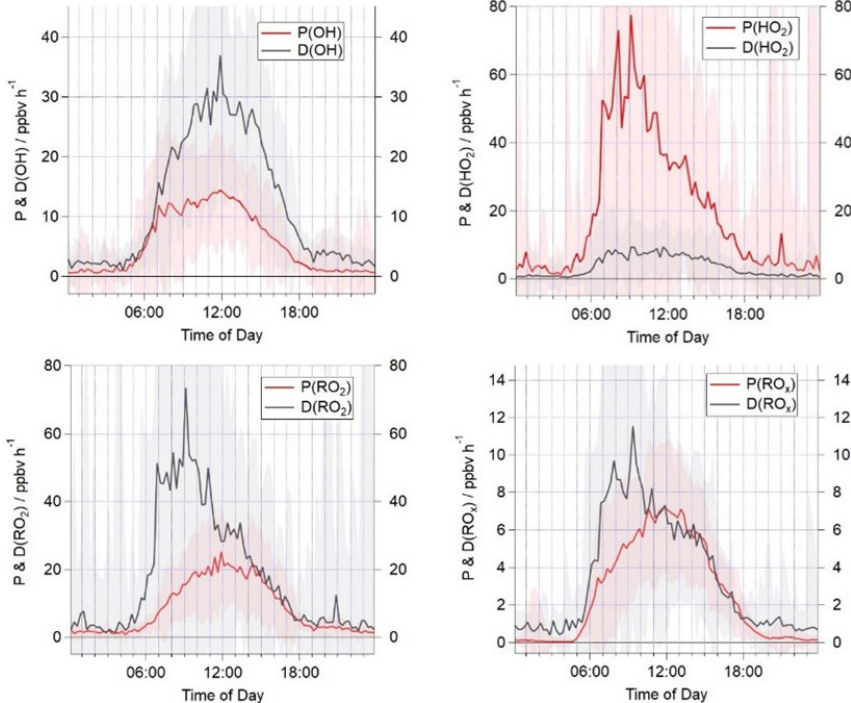
Figure 3. Campaign median production and destruction rates for OH, HO 2 , total RO 2 and RO x . The shaded areas represent the 1 σ standard deviation of the data, representing the variability from day to